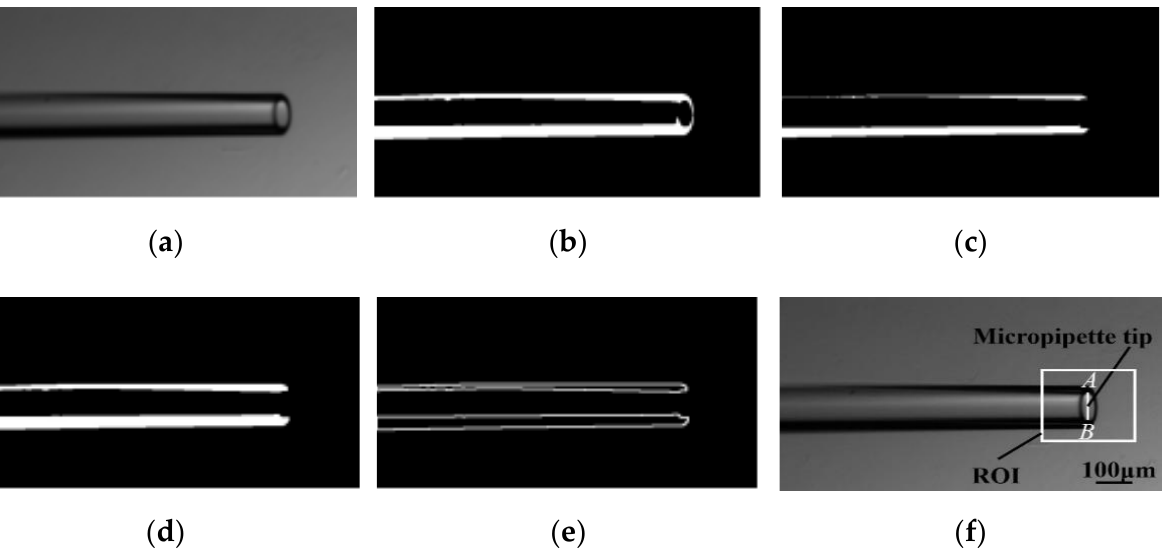
Figure 2. Image sequence of micropipette tip identification. ( a ) Gaussian low-pass filter for denoising image; ( b ) Thresholding method for binarizing low-noise image; ( c , d ) Morphological erosion and dilation for eliminating small objects in the binarized image; ( e ) Contour detection for finding the top and bottom edges of micropipette walls; ( f ) Micropipette tip detected at the rightmost end of micropipette wall edges by finding the point A and the point B. Point A is the rightmost point on the top edges of micropipette walls; Point B is the rightmost point on the bottom edges of micropipette walls.